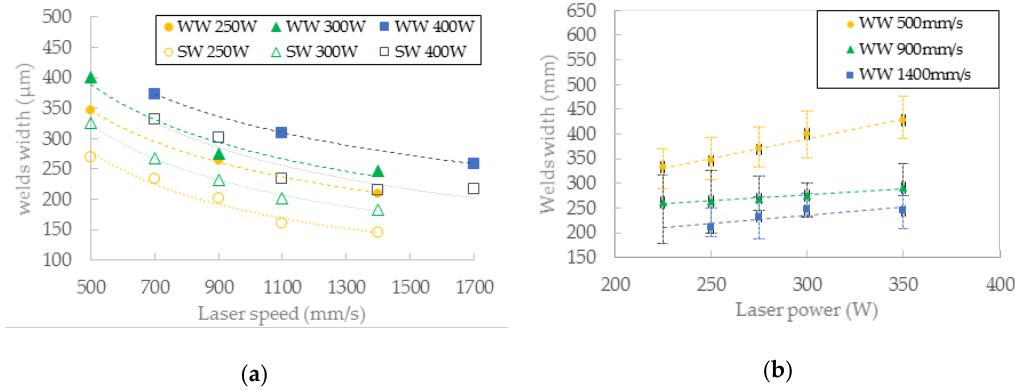
Figure 14. ( a ) Comparison of single welds and walls width according to LS —in chart (SW) single weld width; (WW) wall width; ( b ) the wall width according to LP